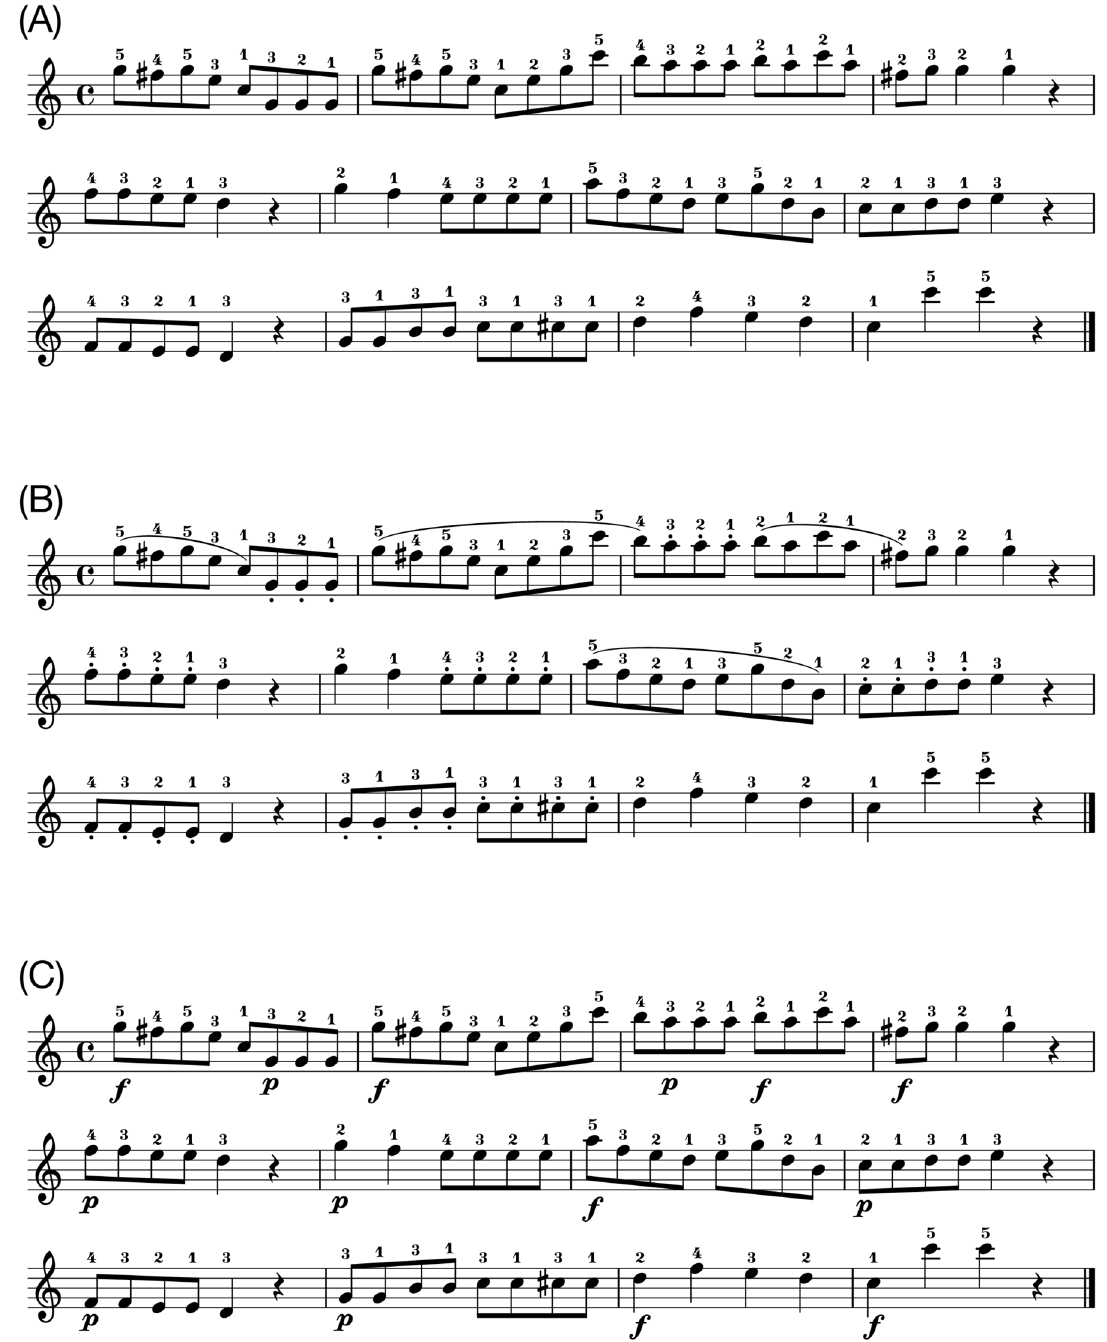
Figure 5. ( A ) Original sheet music. ( B ) Articulation. The curved line (slur) indicates legato and the dots indicate staccato. ( C ) Dynamics. The symbol ‘f’ denotes forte and the symbol ‘p’ denotes piano. For data analysis, only the 8th notes were